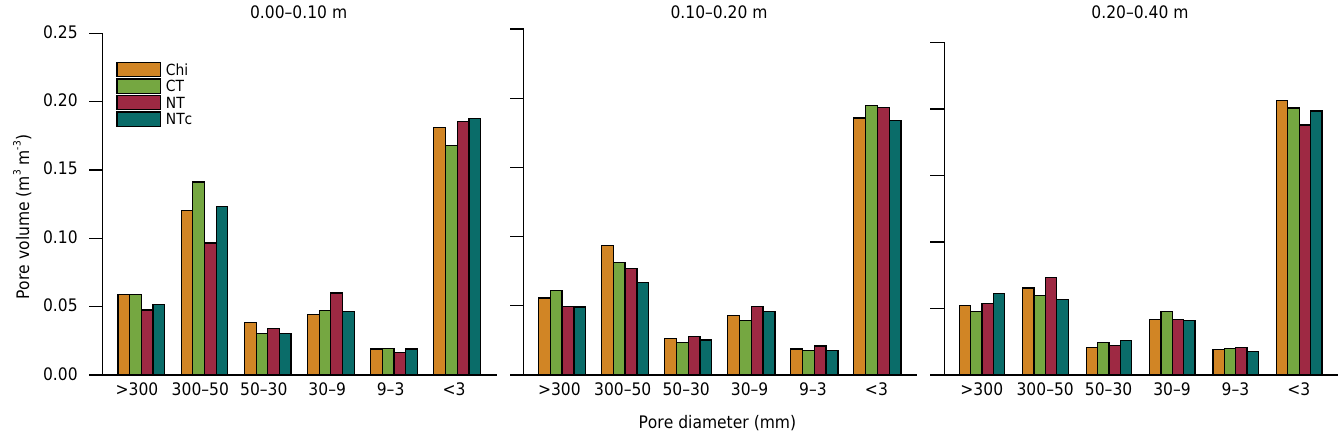
Figure 3. Pore size distribution (PSD) for chisel (Chi), conventional tillage (CT), no-tillage (NT), and compacted no-tillage (NT C ), in three soil layers.